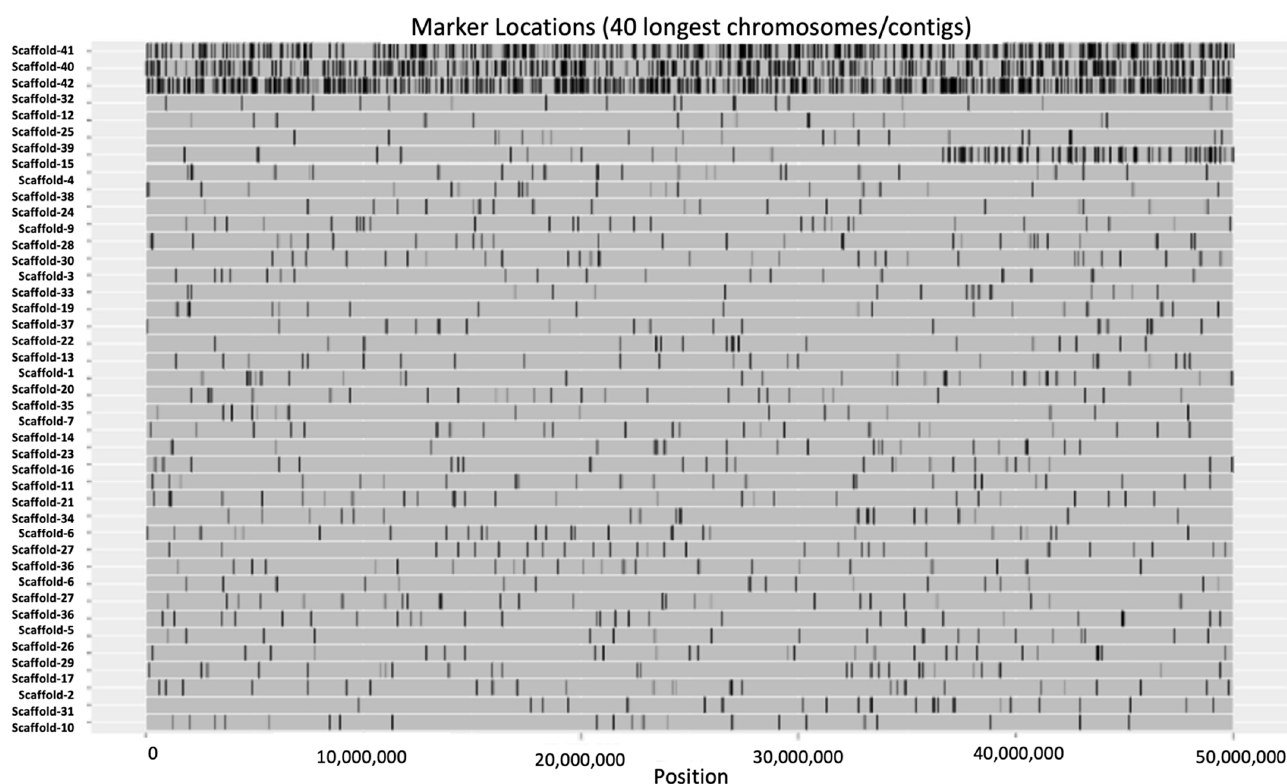
Figure 2. Variant density plot of Rhanterium eppaposum genotypes. Each row is represented by a scaffold of 50 Gb length. The black lines denote the SNPs and indels. The top three scaffolds were highest in variant density.